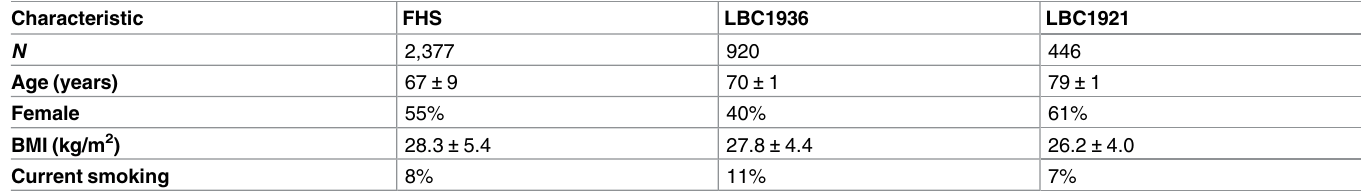
Table 2. Study characteristics of the Framingham Heart Study and Lothian Birth Cohort participants (discovery cohorts) at the time of DNA meth- ylation assays.